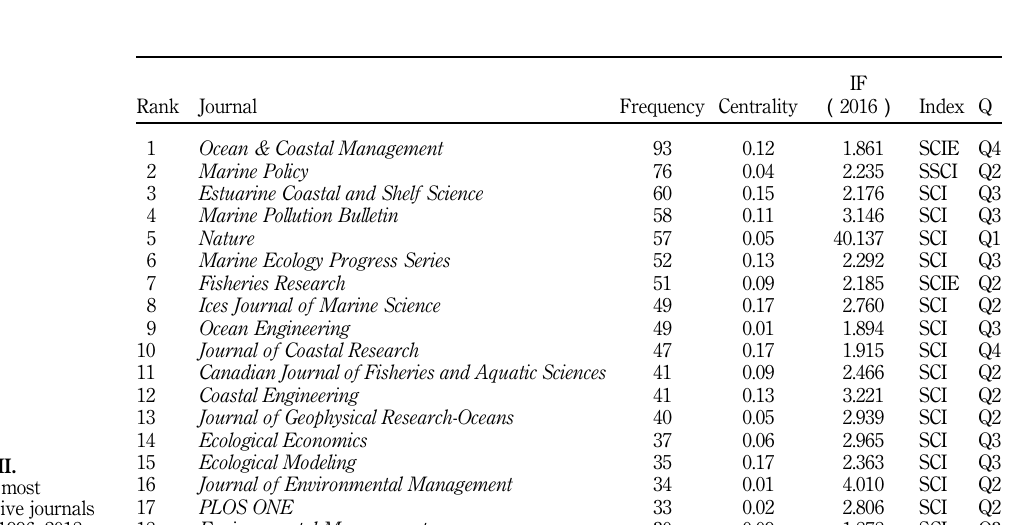
productive journals during 1996 –